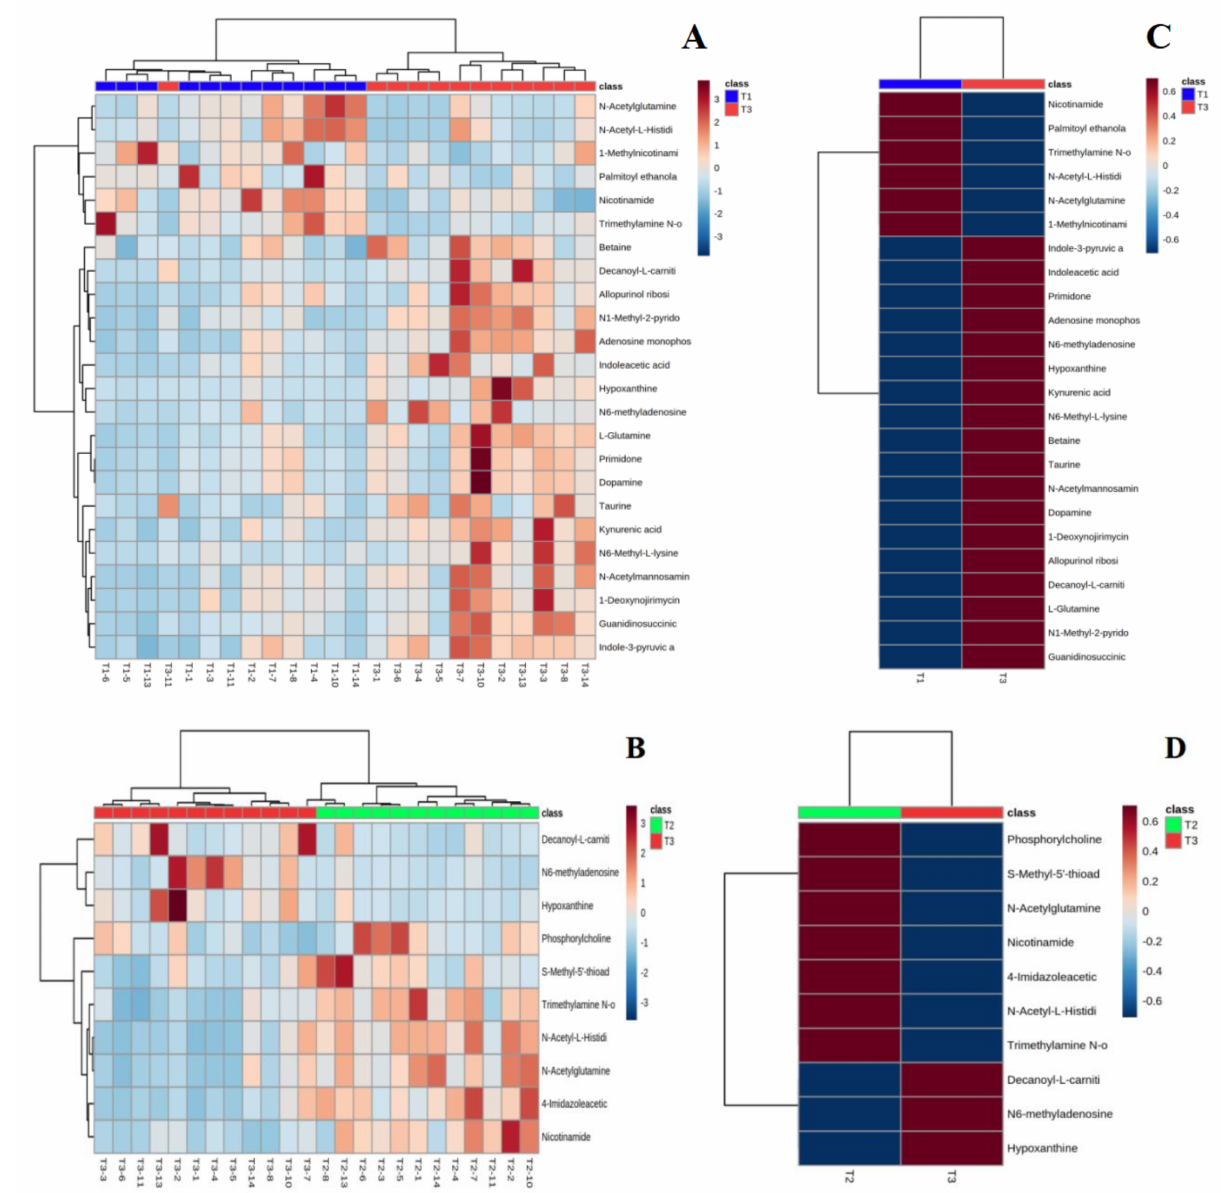
Figure 5. Urine metabolite clustering plots ( A , B ) and mean metabolic expression clustering plots between groups ( C , D